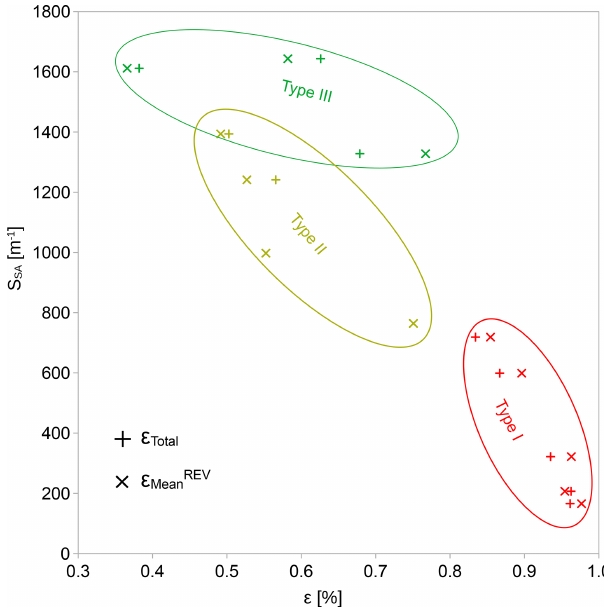
Figure 10. Specific surface (m − 1 ) as a function of total porosity ε Total (%) and representative elementary averaged porosity ε REV mean (%).